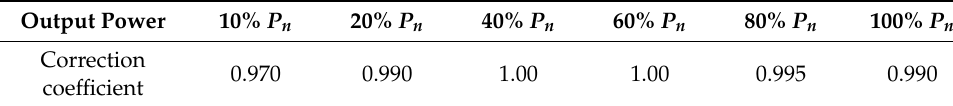
Table 2. Converter efficiency correction reference table.